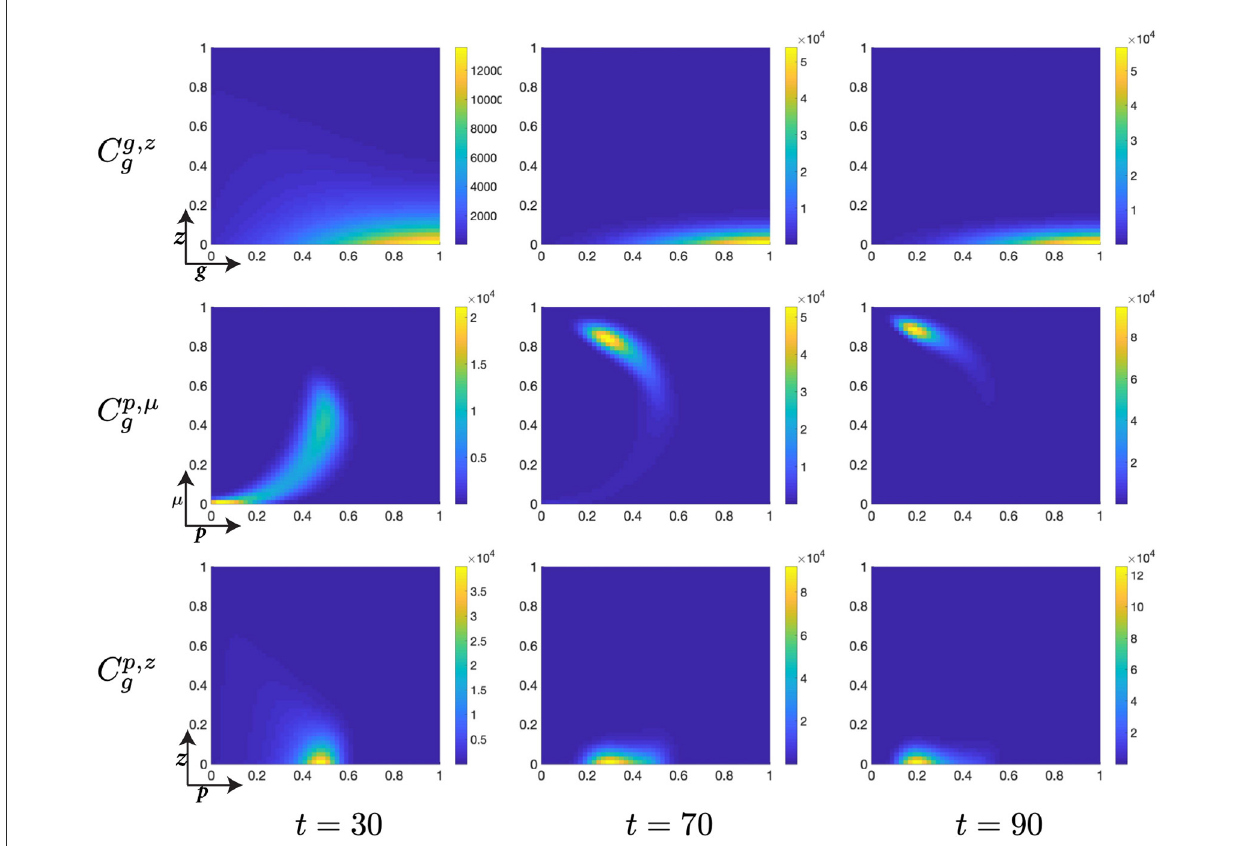
FIGURE10 Structured G-phase cell population given in: the G-cyclin-DNA-damage plane ( g , z ); the p53-mdm2 plane ( p , µ ); and the p53-DNA-damage plane, solved for t 30, 70, 90 , ∈ { }